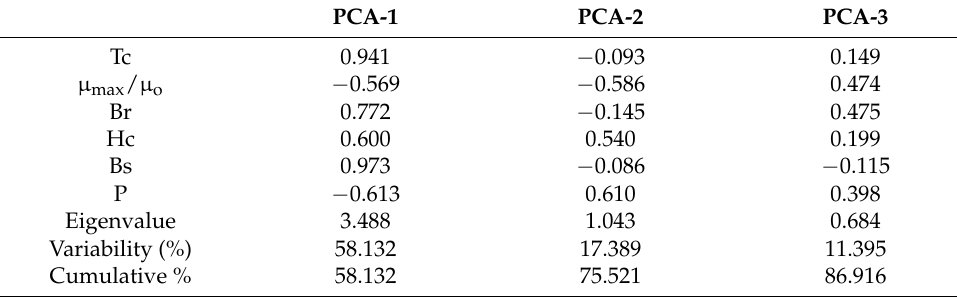
Table 5. Characteristic loading and Eigen values of magnetic